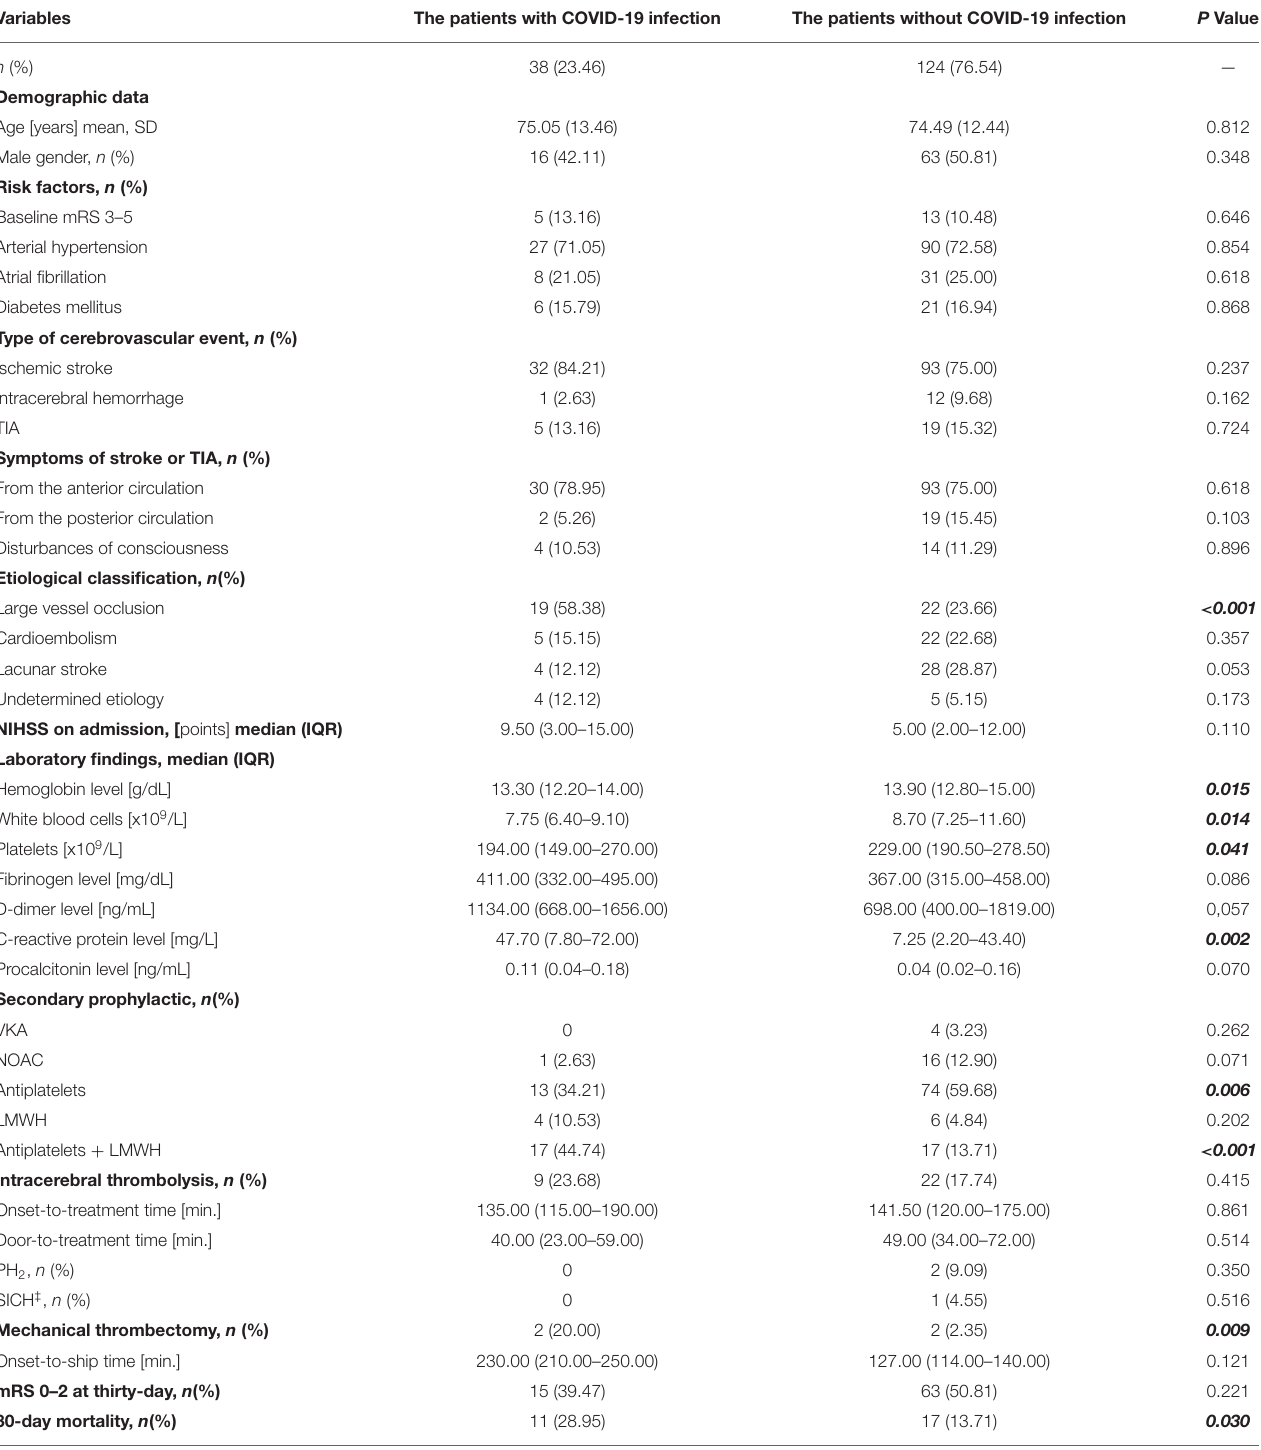
TABLE 2 | The clinical characteristics of the subgroups of patients with cerebrovascular diseases and COVID-19 infection. Variables The patients with COVID-19 infection The patients without COVID-19 infection P